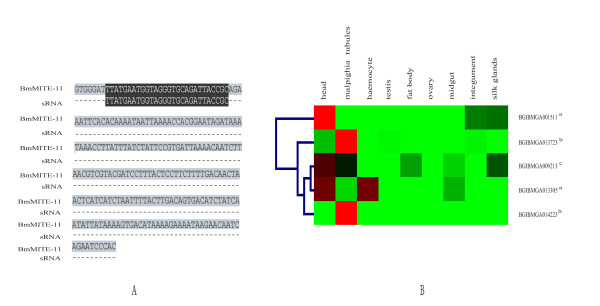
BmMITE-11 containing the small RNA and expression profiles of its the closest genes. (A) The alignment of BmMITE-11 and small RNA (RNA-36850, Genbank accession no. AB423040). (B) Expression profiles of the closest genes to which BmMITE-11 is located. Red indicates upregulated genes, green down-regulated genes, black no expression change. a, b, c represent the closest genes with BmMITE-11 inserted into their introns, 3` flanking and 5`flanking regions, respectively.